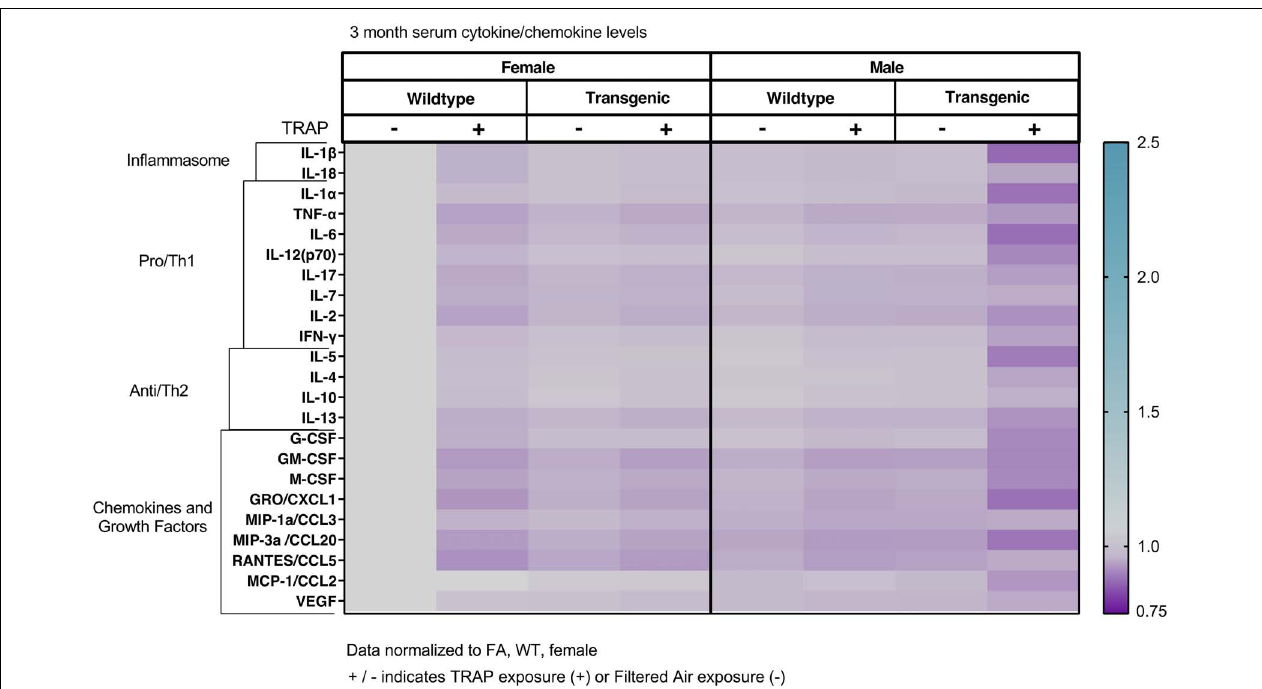
FIGURE 2 | Heat map representation of serum cytokine, chemokine, and growth factor changes in response to TRAP in 3-month old TgF344-AD and WT rats. Serum levels of cytokines and growth factors in TgF344-AD and WT rats exposed to FA or TRAP for 2 months were analyzed using multiplex technology. For each analyte, individual values were normalized to the mean level of that same analyte in sera from female FA WT animals. Purple indicates normalized protein levels < 1.0; turquoise indicates normalized protein levels > 1.0. ± indicates exposure with + identifying TRAP-exposed animals; - indicating FA-exposed animals; n = 4–5 animals per group (duplicate samples were analyzed for each animal). Non-normalized cytokine values for female FA WT animals are provided in Supplementary Table 1